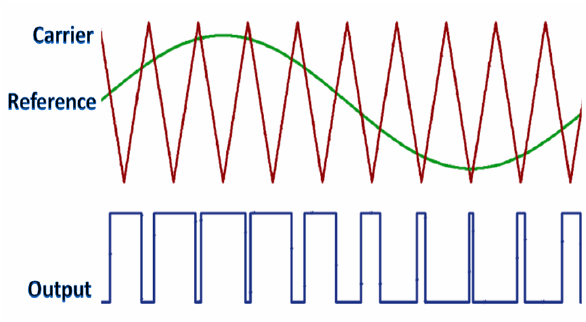
Figure 8. Outputsignal from the modulator: CC- AC Converter